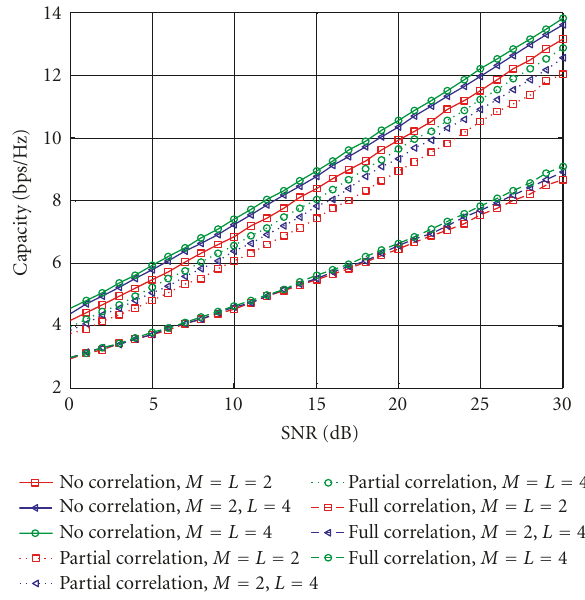
Figure 5: Ergodic capacity with di ff erent eigenvalue spreads and numbers of transmit antennas and channel paths.